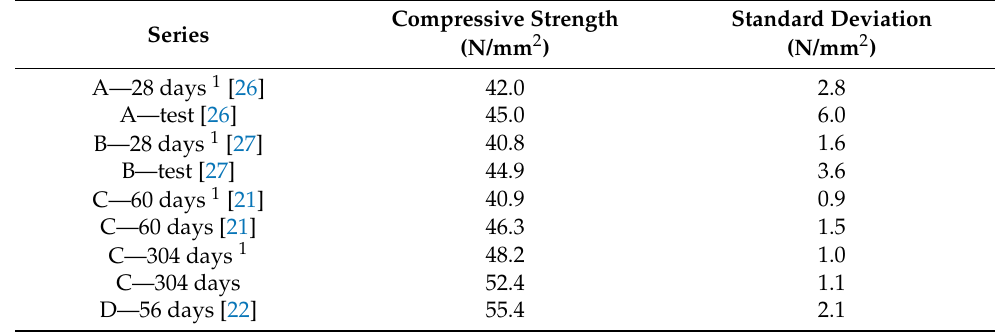
Table 2. Mean compressive cube strength of concrete